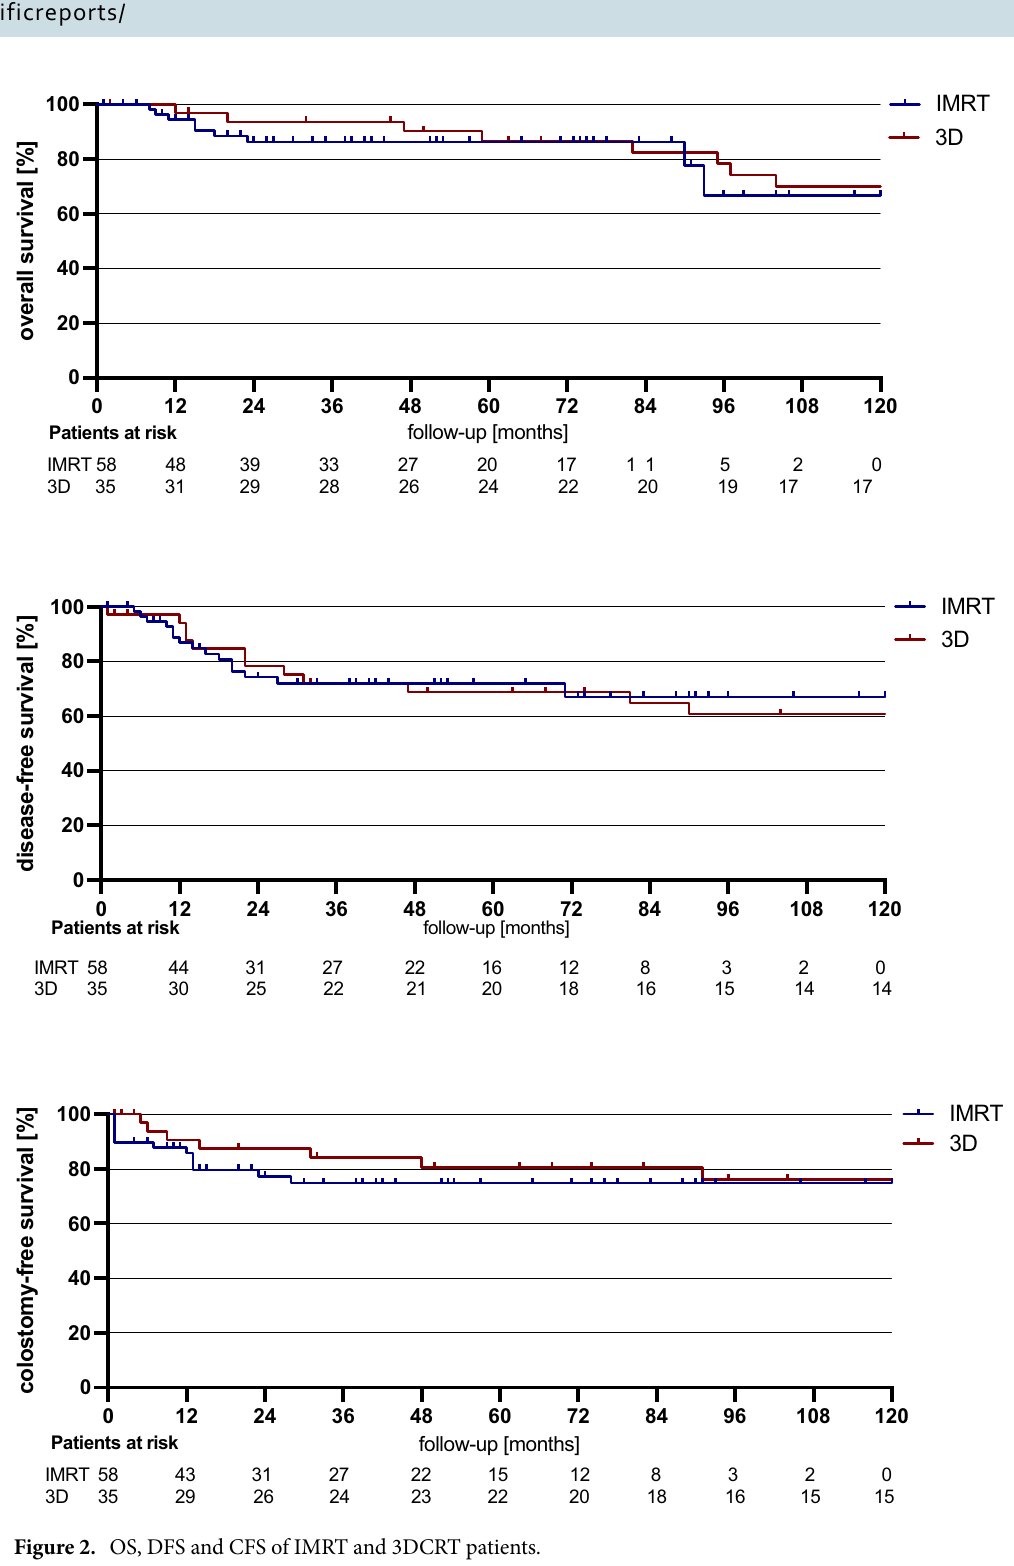
Figure 2. OS, DFS and CFS of IMRT and 3DCRT